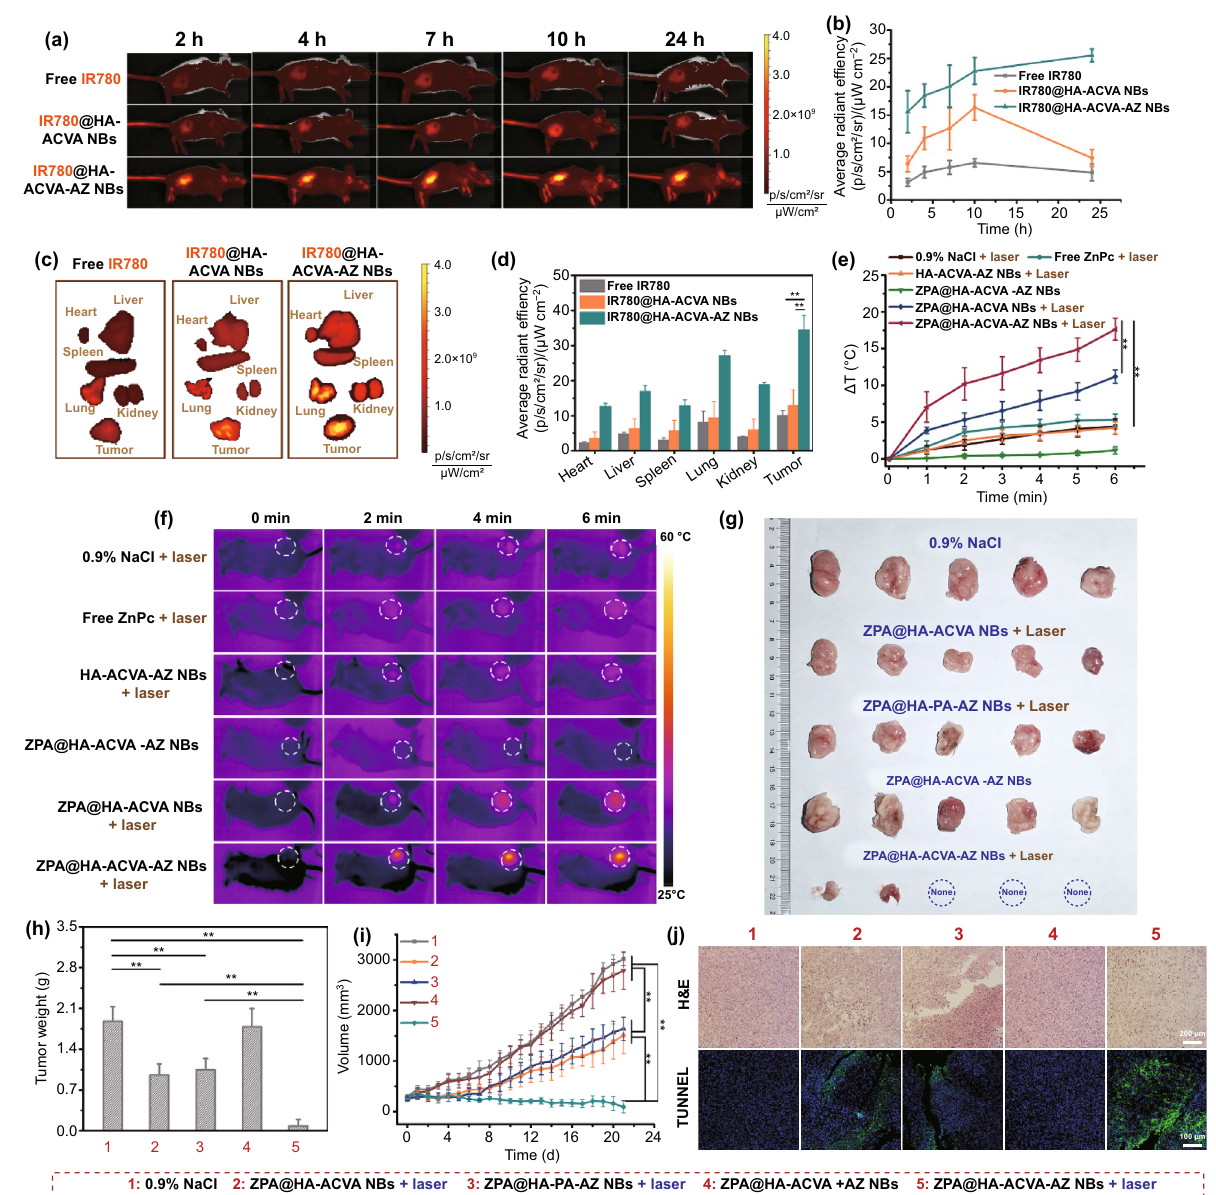
Fig. 4 Biodistribution, in vivo photothermal performance and tumor inhibition ability of ZPA@HA-ACVA-AZ NBs. a NIR fluorescence imag- ing of balb/c mice bearing subcutaneous 4T1 tumors intravenously administrated with IR780@HA-ACVA-AZ NBs, IR780@HA-ACVA NBs and free IR780 at 2 h, 4 h, 7 h, 10 h and 24 h. b Average fluorescence intensity of IR780 in the tumor over time was measured with an in vivo imaging system. c Ex vivo NIR fluorescence imaging of IR780 fluorescence intensity in the harvested organs and tumors at 24 h post-adminis- tration ( n = 4). d Quantitative analysis of IR780 fluorescence intensity in the harvested organs and tumors at 24 h post-administration. e Tem- perature change and f infrared thermal imaging at the tumor site of mice bearing 4T1 tumors treated with different drug formulations via the tail vein upon 808-nm laser irradiation (1 W cm −2 , 10 min) ( n = 4). g Morphology and h weight of tumors at the 21 days post-injection of 0.9% NaCl, ZPA@HA-ACVA NBs, ZPA@HA-PA-AZ NBs and ZPA@HA-ACVA-AZ NBs with or without laser exposure (1 W cm −2 , 5 min). i Tumor growth profiles from each group ( n = 5). j H&E and TUNEL stained images of the tumors from mice treated with various drug formula- tions on day 7 ( n =